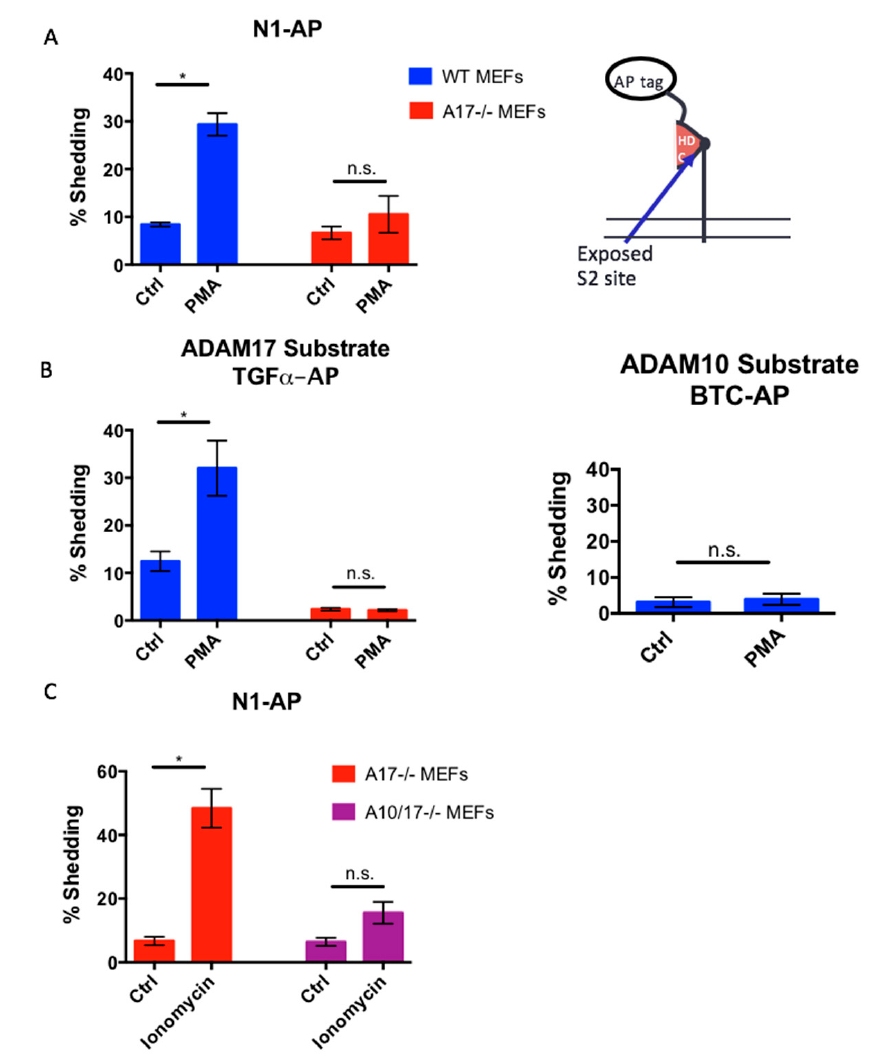
Figure 5. The constitutively exposed Notch1 S2 site behaves like an ADAM17 substrate. ( A ) WT and A17-/- mEFs were transfected with a truncated Notch1 receptor, consisting of the C -terminal portion of the receptor starting from amino acid residue 1687 within the C -terminal part of the heterodimerization domain, with an alkaline phosphatase tag attached to its N -terminus (Notch1-AP or N1-AP), and were stimulated with the ADAM17-selective stimulus PMA [52]. WT mEFs stimulated with 25 ng/mL of PMA had increased shedding of N1-AP over untreated WT mEFs. There was no significant increase in the PMA-induced shedding of N1-AP in A17-/- mEFs. ( B ) N1-AP shedding thus behaved similarly to the shedding of TGF α -AP, a known ADAM17 substrate [35,52], which could be stimulated by PMA in WT mEFs, but not in A17-/- mEFs. In contrast, PMA treatment did not result in the shedding of an established ADAM10 substrate, betacellulin-AP (BTC-AP) [52]. ( C ) In A17-/- mEFs treated with 2.5 µ M of ionomycin, which strongly stimulates ADAM10 and ADAM17, N1-AP shedding was increased over unstimulated mEFs, whereas there was no statistically significant increase in N1-AP shedding in A10/17-/- mEFs treated with ionomycin, suggesting that ADAM10 can shed N1-AP in the absence of ADAM17. All the data are shown as mean ± standard error of the mean (SEM) for n ≥ 3 independent experiments. An * indicates p < 0.05 and n.s. indicates no statistically significant difference using the unpaired two-tailed Student’s t